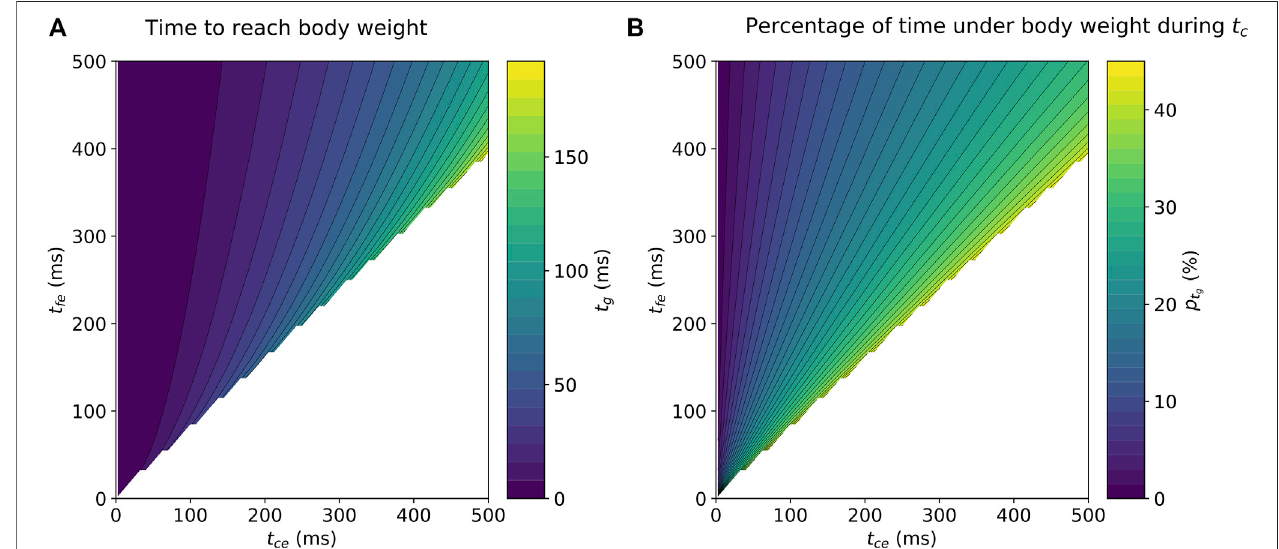
FIGURE2| Contourplotsdepictinga)thenumericallycalculatedtime ( t g ) necessarytoreachbodyweightandB)thecorrespondingpercentage( p t body weight during ground contact time ( t c ) . The numerical simulation assumed a sine wave model for vertical ground reaction force and was performed over the t ce x t fe